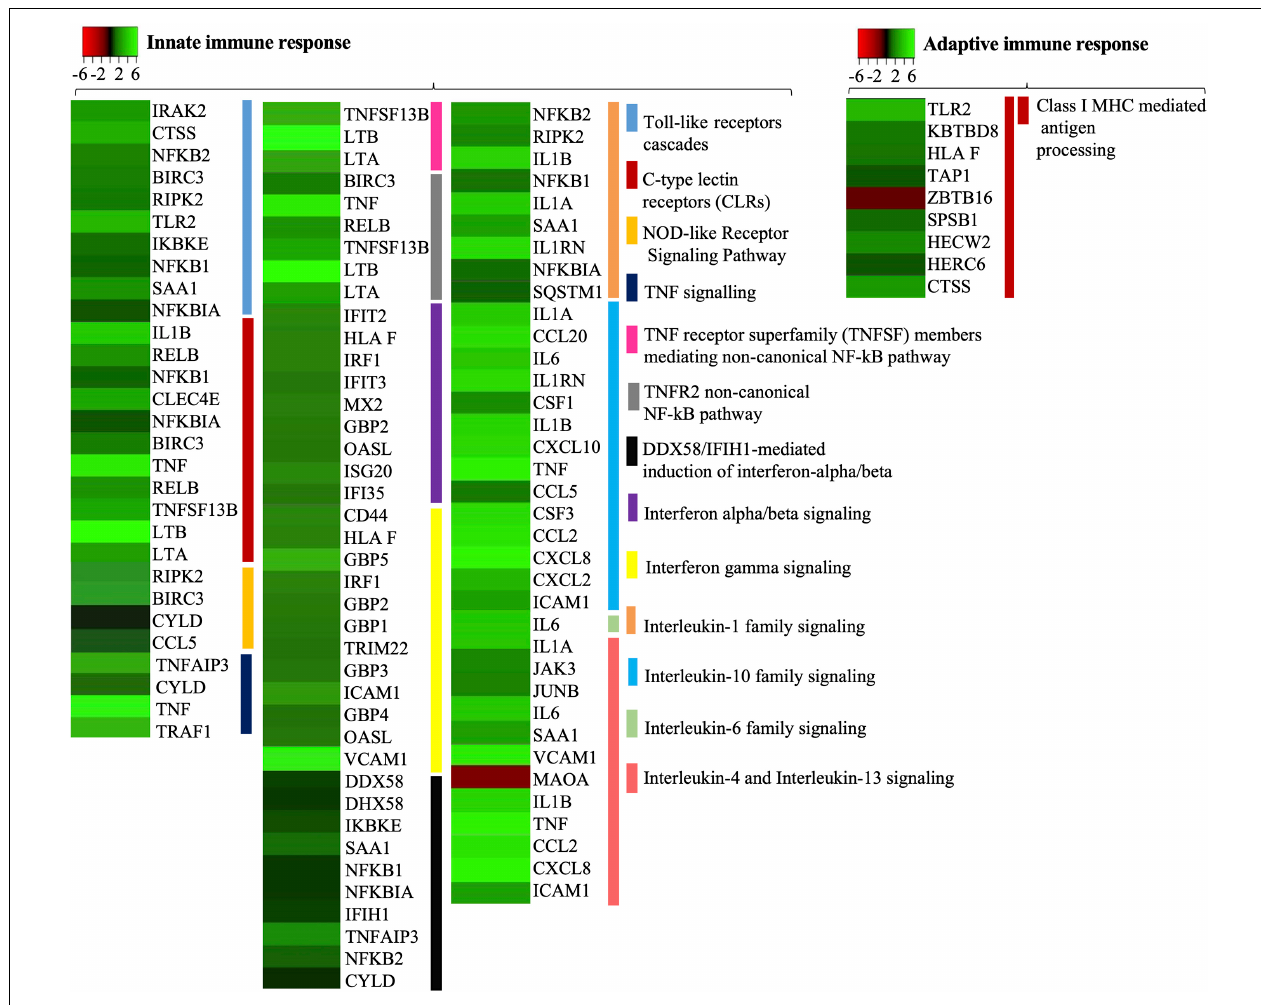
FIGURE 4 | The differentially expressed genes related to the immune response in hBMECs activated by B. bavariensis . Heat maps showing biological processes related to the immune response. Green shaded genes—upregulated, red shaded genes—downregulated. The intensity of the color indicates the degree of expression level. The range of the fold change (logFC) is presented in the